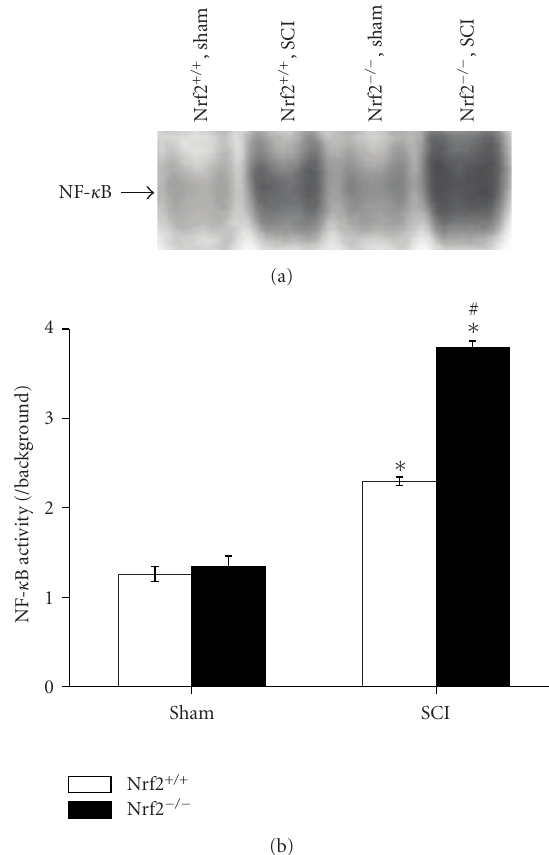
Figure 3: NF- κ B activity in the spinal cord segments of sham and injured Nrf2 (+/+) and Nrf2 ( − / − ) mice. (a) Representative X-ray film shows NF- κ B DNA binding activity by EMSA at 24 h after SCI in sham and injured Nrf2 (+/+) and Nrf2 ( − / − ) mice. (b) Quantification of NF- κ B DNA-binding activity was performed by densitometric analysis. The figure indicates that spinal cord NF- κ B activity was significantly increased after SCI and was greater in Nrf2 ( − / − ) mice than in Nrf2 (+/+) mice. Data represents mean ± S.E. ( n = 6 per group). ∗ P < . 01 versus sham control of the same genotype. P < . 01 versus injured wild-type